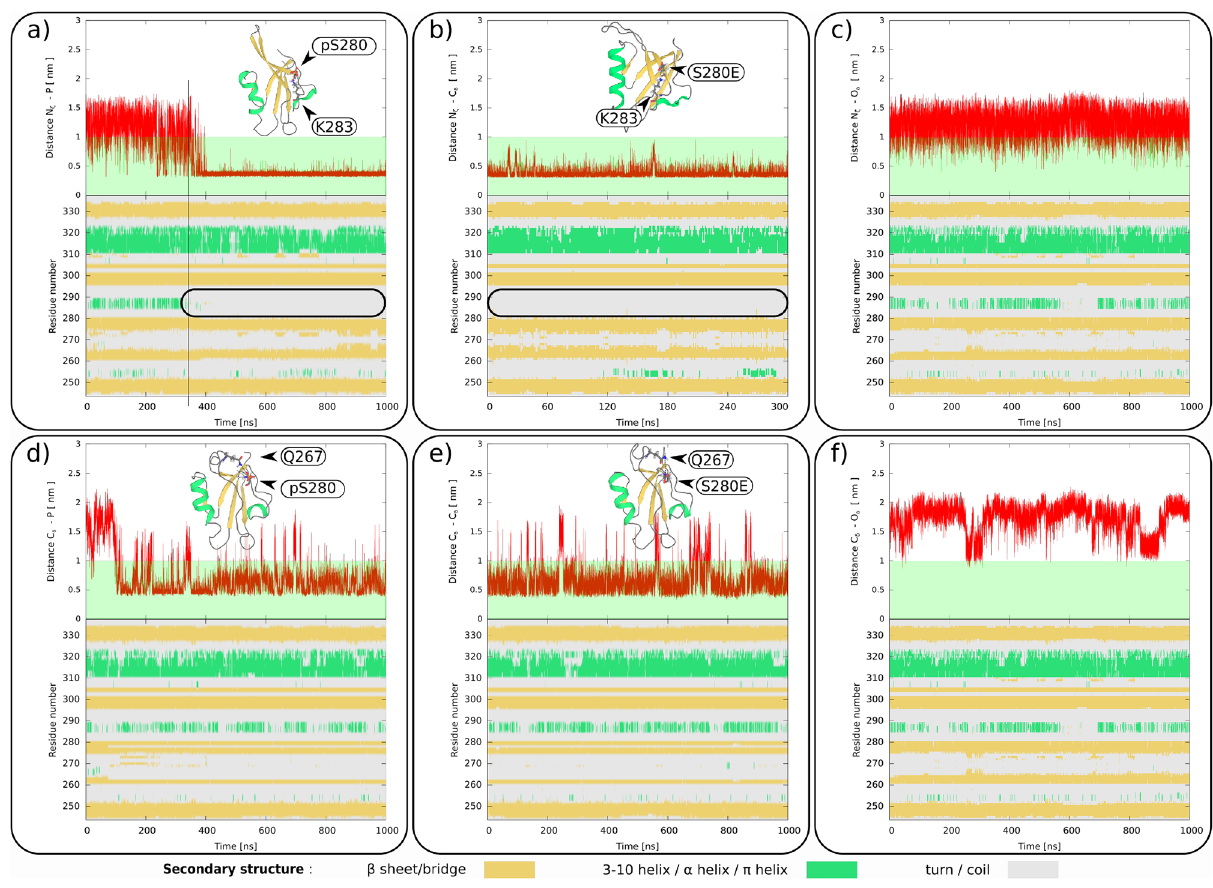
Figure 4. The top row ( a – c ) depicts the time evolution of the distances between N ζ of K283 and ( a ) phosphate of pS280, ( b ) C δ of S280E or ( c ) O δ of S280 in pS280, S280E and wt systems respectively. The bottom row ( d – f ) depict the time evolution of the distances between C δ of Q267 and ( d ) phosphate of pS280, ( e ) C δ of S280E or ( f ) O δ of S280 in pS280, S280E and wt systems respectively. Snapshot of the PDZ with highlighted interacting residues is displayed in the inlet. In the bottom of each panel is the time evolution of the PDZ secondary structure (color coding: below the